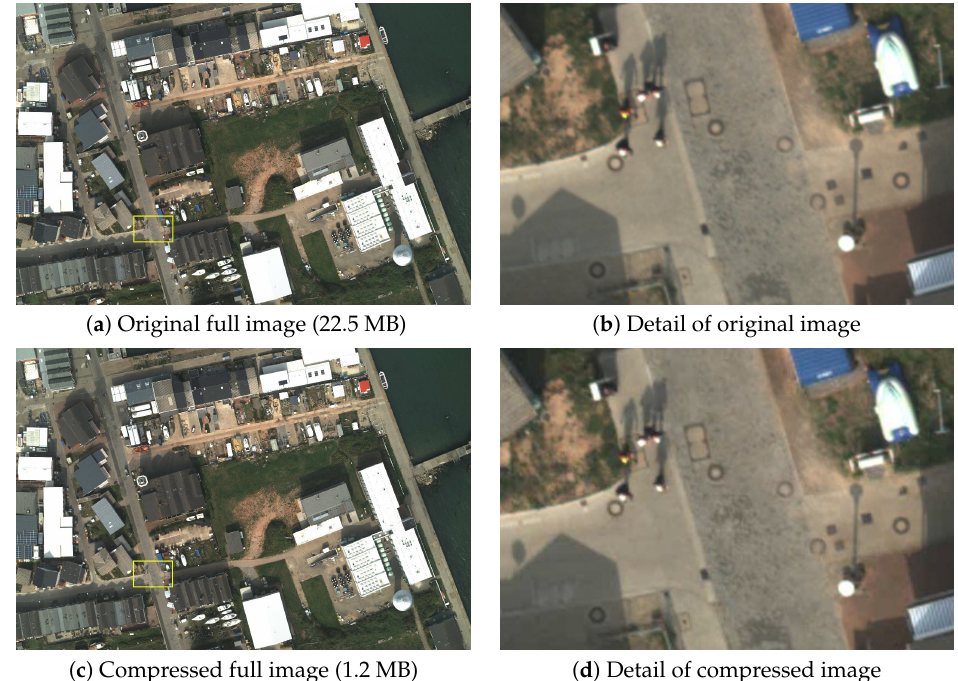
Figure 6. JPEG compression result on sample aerial image with an image resolution of 4864 × 3232 pixels, 12-bitradiometricdepth(whichcorrespondstoarawimagedatasizeof22.5MB),anda groundsamplingdistance (GSD) of 5 cm per pixel: ( a , c ) full image: and ( b , d ) detail view of the yellow rect section in the full